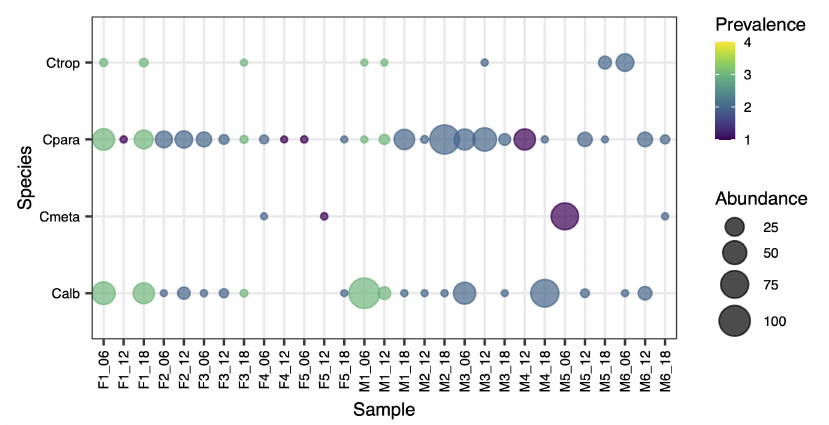
Figure 2. Bubble plot depicting the prevalence and relative abundance of opportunistic pathogenic Candida species in the preterm infant gut mycobiome (Calb, C. albicans ; Cmeta, C. metapsilosis ; Cpara, C. parapsilosis ; Ctrop, C. tropicalis